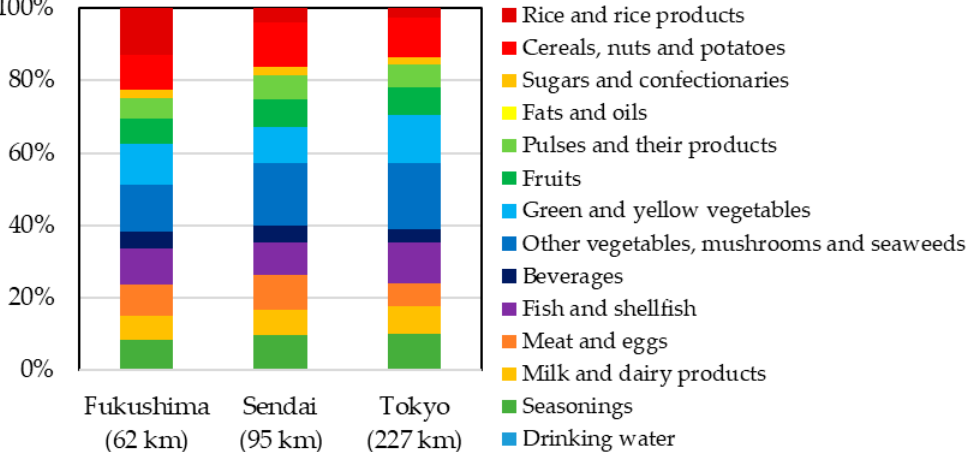
Figure 4. Percentage contributions of food groups to the committed e ff ective doses of 40 K in 2011. Distance from the Fukushima Daiichi nuclear power plant to each city is denoted in parentheses. This figure was modified from [19].